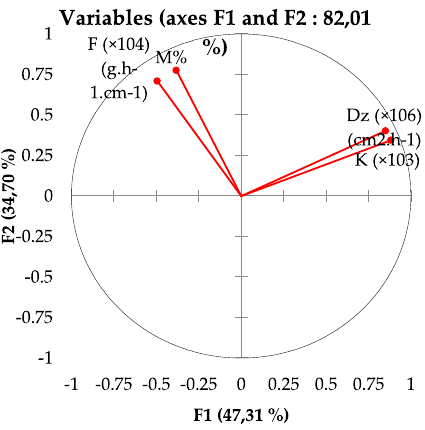
Fig. 5. Mapping of correlations between parameters of EOCa desorption and insecticidal